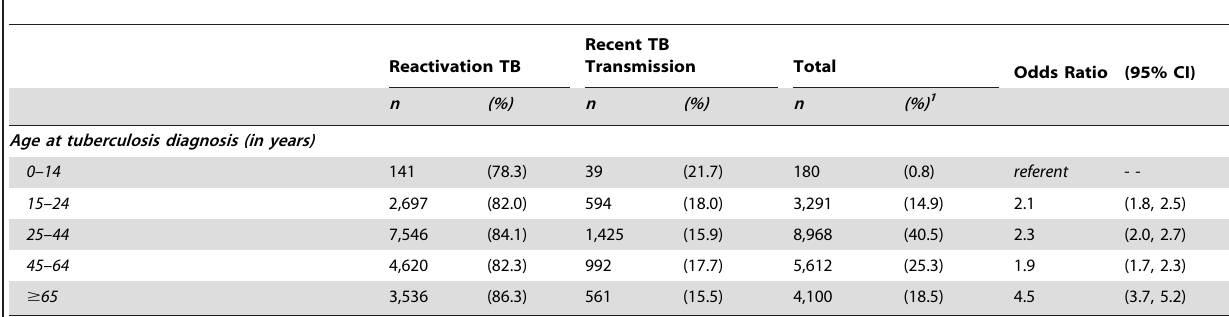
Table 3. Proportion of reactivation TB among foreign-born TB cases by age at tuberculosis diagnosis, United States 2005–2009.